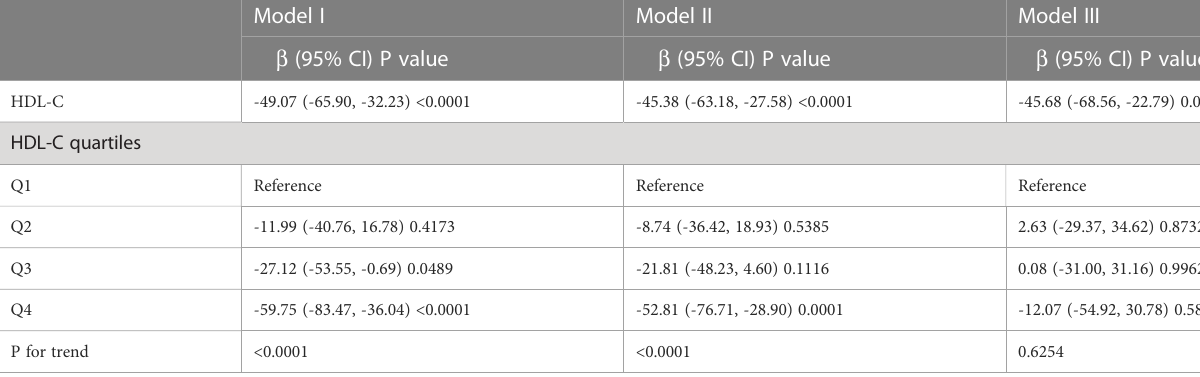
TABLE 3 Weighted regression models and trend tests elucidate the correlation between HDL-C and blood eosinophil